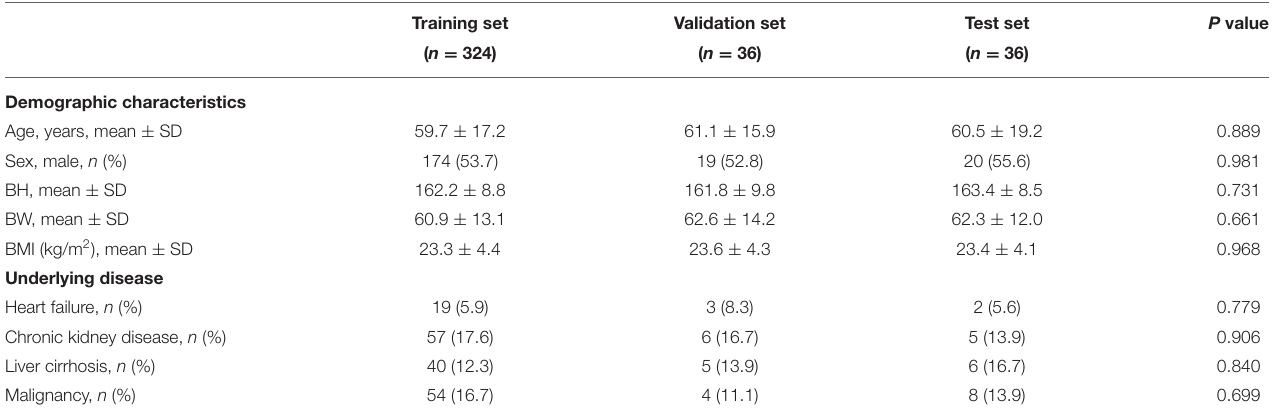
TABLE 1 | Demographic data of patients.